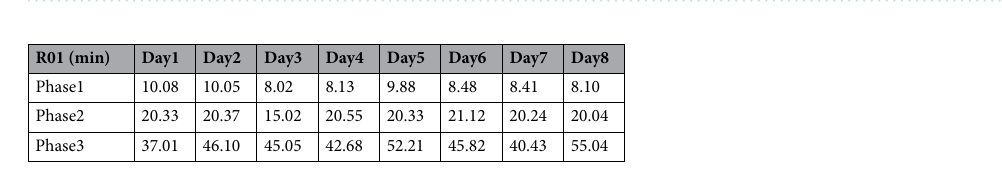
Figure 4. Dataset: trajectories of animal R01 across 8 days, 3 phases every day. See the main text for explanation.